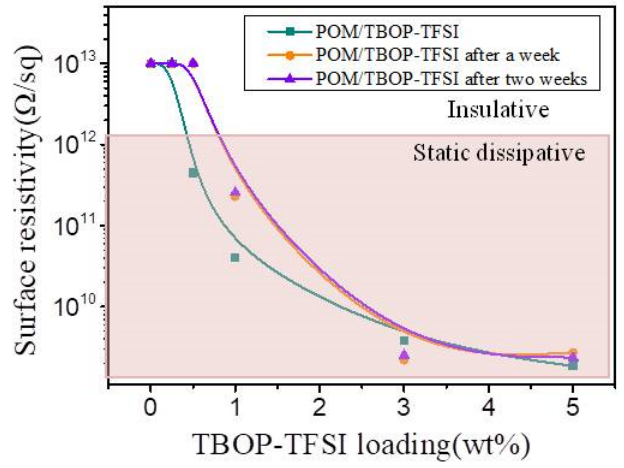
Figure 6. Surface resistivity of POM/TBOP-TFSI composites.